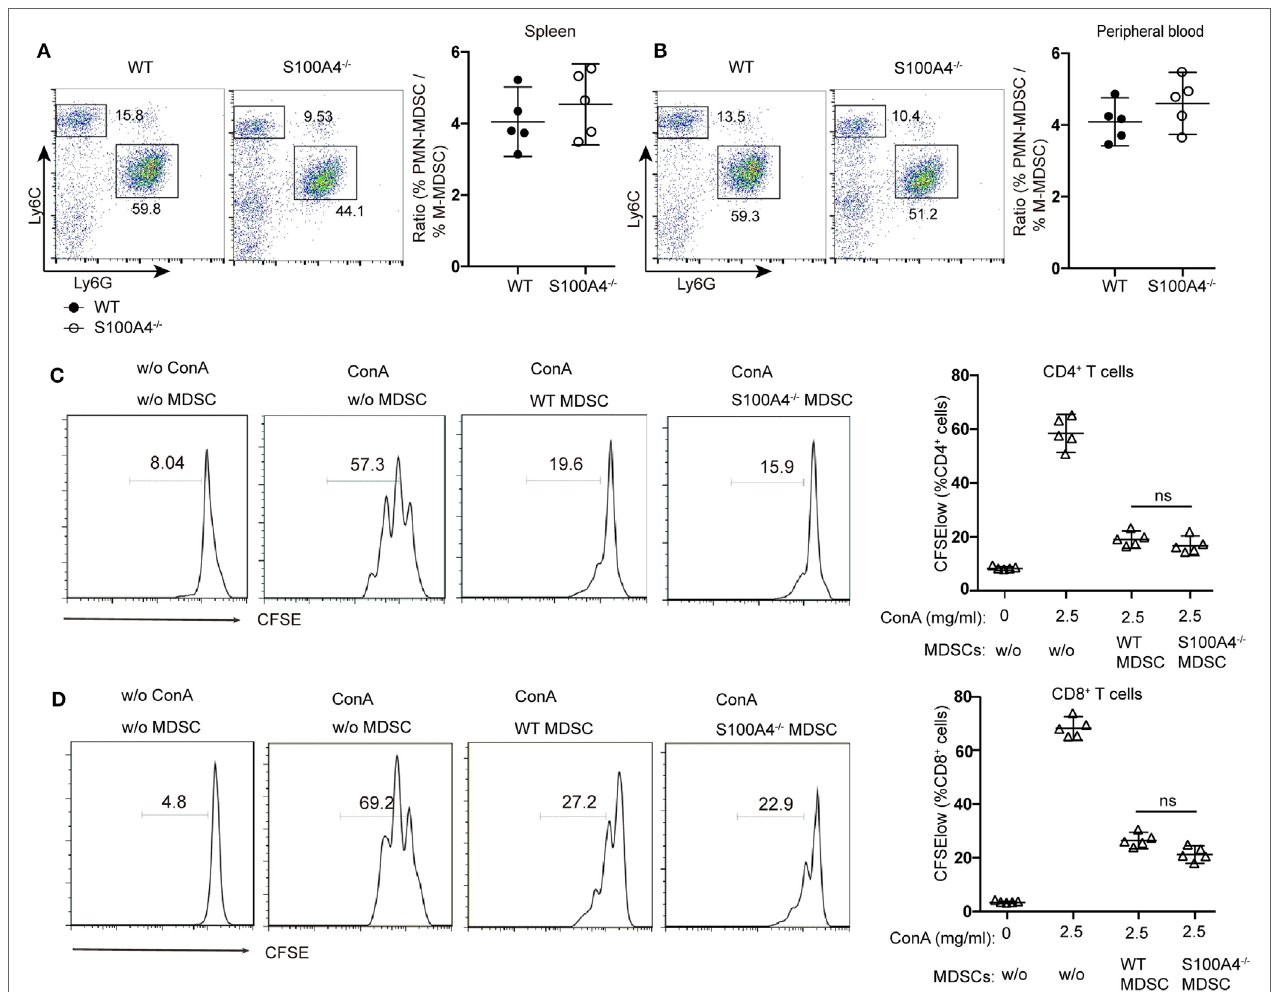
FigUre 2 | Functionality of myeloid-derived suppressor cells (MDSCs) in S100A4 − / − mice. (a,B) wild type (WT) and S100A4 − / − mice were subcutaneously injected with 5 × 10 5 MCA205 cells. Seventeen days after tumor-cell inoculation, cells isolated from (a) spleen or (B) peripheral blood, stained for CD11b, Ly6C, and Ly6G, were assessed by flow cytometry. Ratios of CD11b + Ly6C hi Ly6G − monocytic (M − )MDSCs and CD11b + Ly6C low Ly6G + polymorphonuclear (PMN-)MDSCs are given. Representative results of three independent experiments are shown. Mean and 95% CI, n = 5 mice per group; ** P < 0.01, Mann–Whitney. (c,D) Carboxyfluorescein (CFSE)-labeled tumor-free WT splenocytes were stimulated with concanavalin A. These cells were cultured with or without CD11b + GR1 + cells (1.5 × 10 4 ) derived from the spleens of tumor-bearing WT or S100A4 − / − mice. After 72 h, collected cells were stained for CD4 and CD8. T-cell proliferation was determined by CFSE dilution in gated CD4 + or CD8 + T cells. Combined raw data from three independent experiments are shown. Mean and 95% CI, n = 5 mice per group; ** P < 0.01,